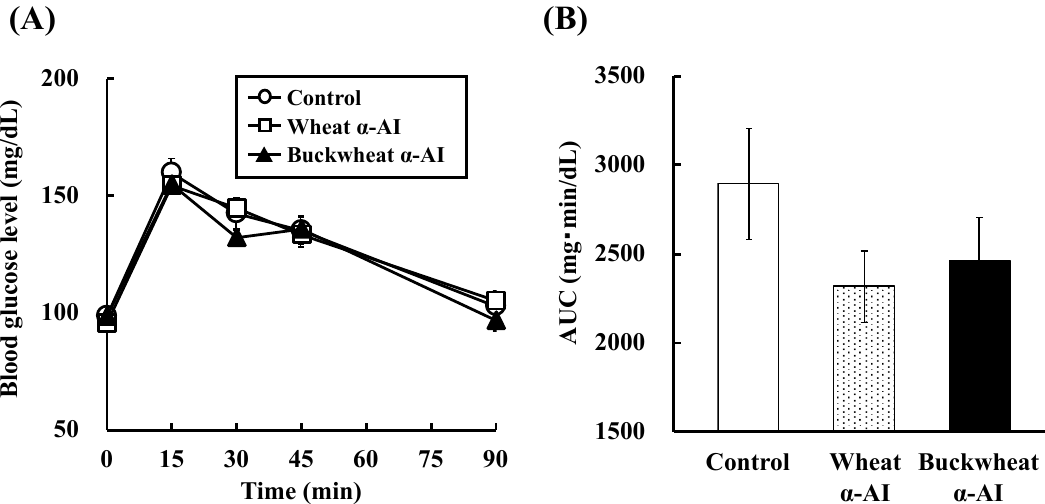
Figure 4. Effect of wheat and buckwheat α -AIs on ( A ) blood glucose level and ( B ) glucose AUC after oral glucose tolerance test using Wistar rats. Each value is the mean of seven experiments with S.E. shown as a vertical bar. Values with different letters are significantly different at p < 0.05.